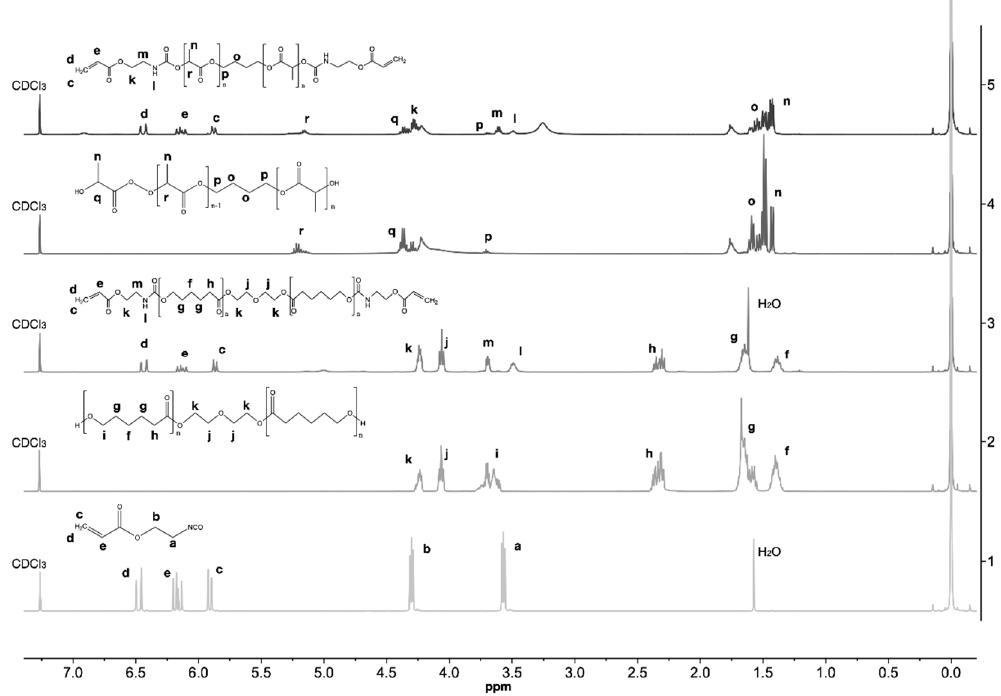
Figure 2. 1 H NMR spectra of ( 1 ) 2-isocyanoethyl acrylate (AOI) ( 2 ) polycaprolactone (PCL) ( 3 ) mPA ( 4 ) oligomers based on lactic acid (oligLA) ( 5 ) mLA in deuterated chloroform (CDCl 3) at 400 MHz.